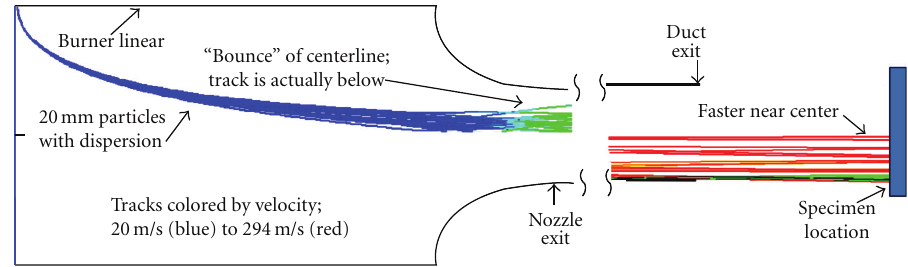
Figure 8: Diagram of trajectories of 20 micron particles in a Mach 0.5 ducted burner rig with turbulent dispersion.